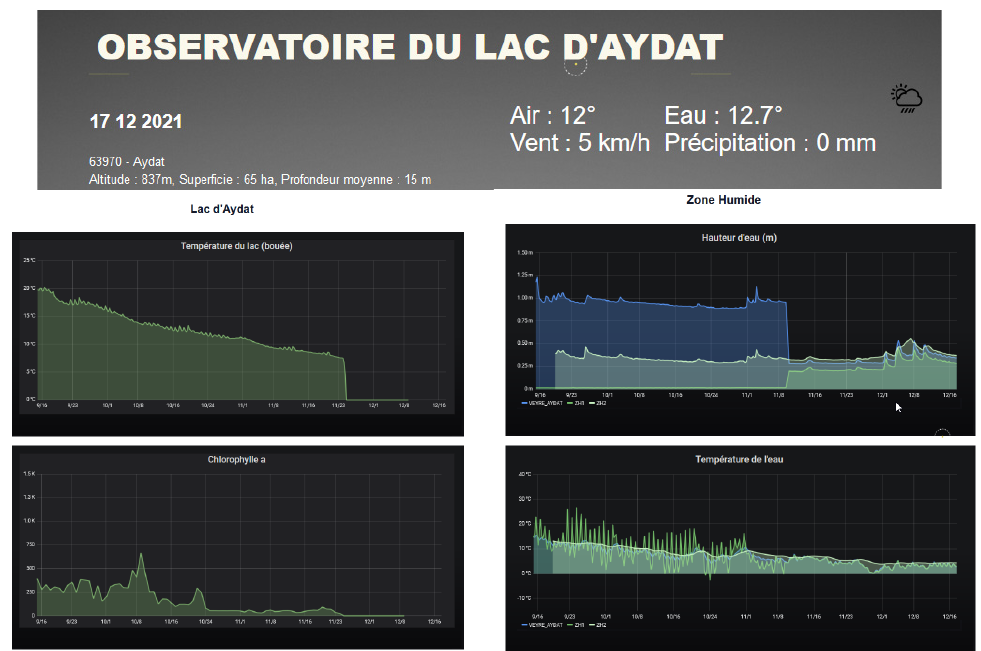
Figure 12. Example of data visualization interface for the Aydat site with an instantaneous KPI (Key Performance Indicator) board on the top and evolution graphs built with Grafana on the bottom.